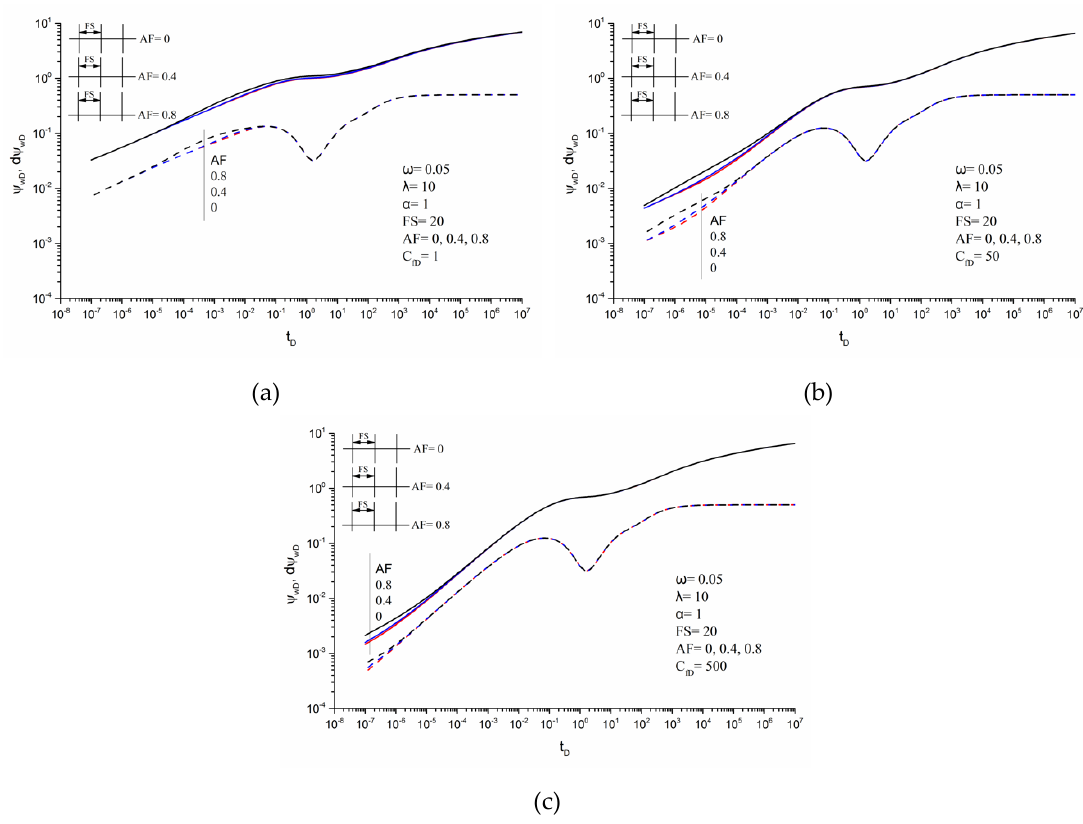
Figure 10. The typical pseudo-pressure curves of a multi-fractured horizontal well with different fracture spacing. ( a ) low conductivity; ( b ) intermediate conductivity; ( c ) high conductivity.